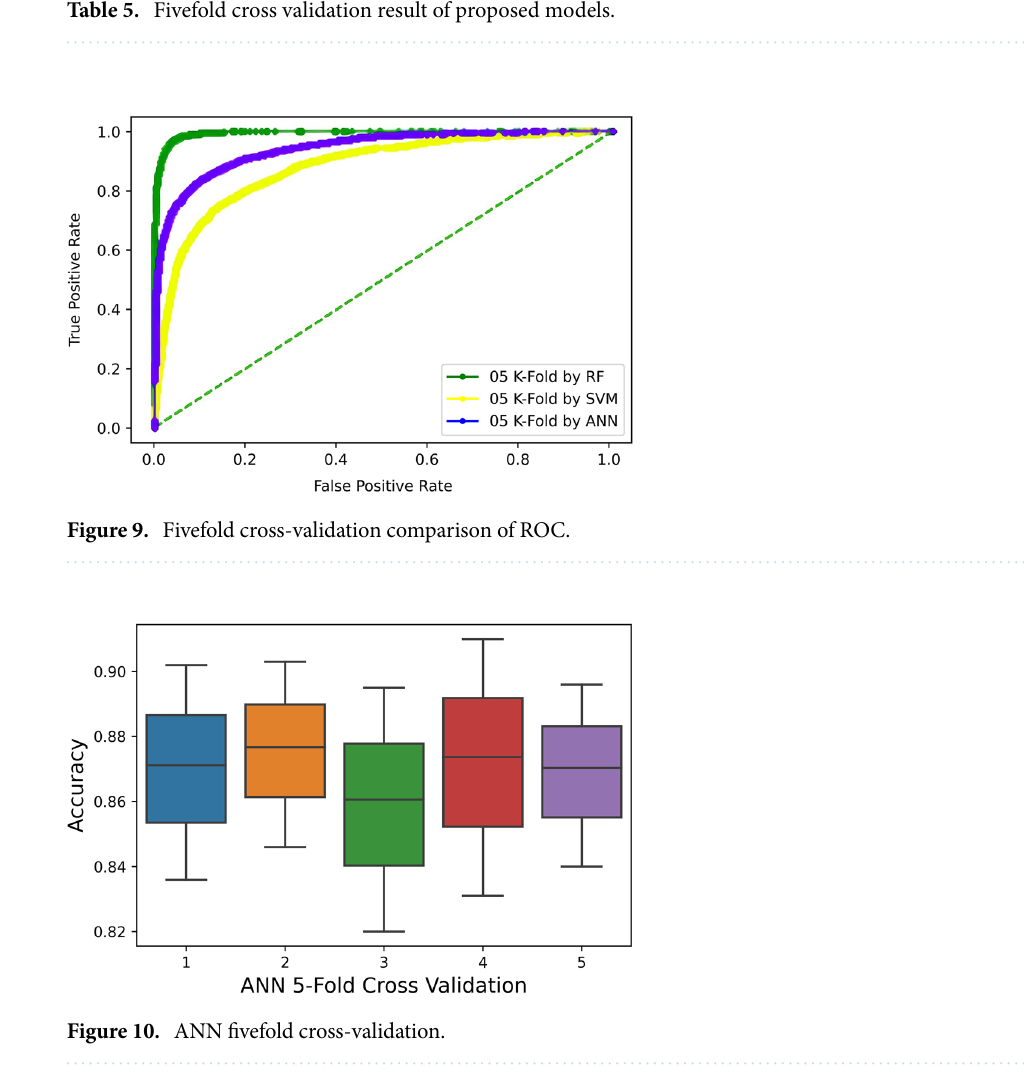
Table 5. Fivefold cross validation result of proposed models.